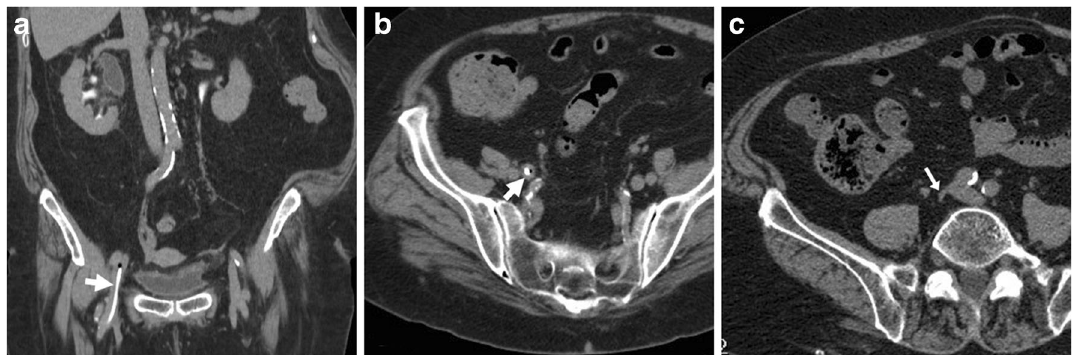
Fig. 12 Long-term venous collapse following central venous catheterisation. On multidetector CT-urography (A, B) performed to in- vestigate urosepsis in a 76-year-old woman, a right femoral CVC (thick